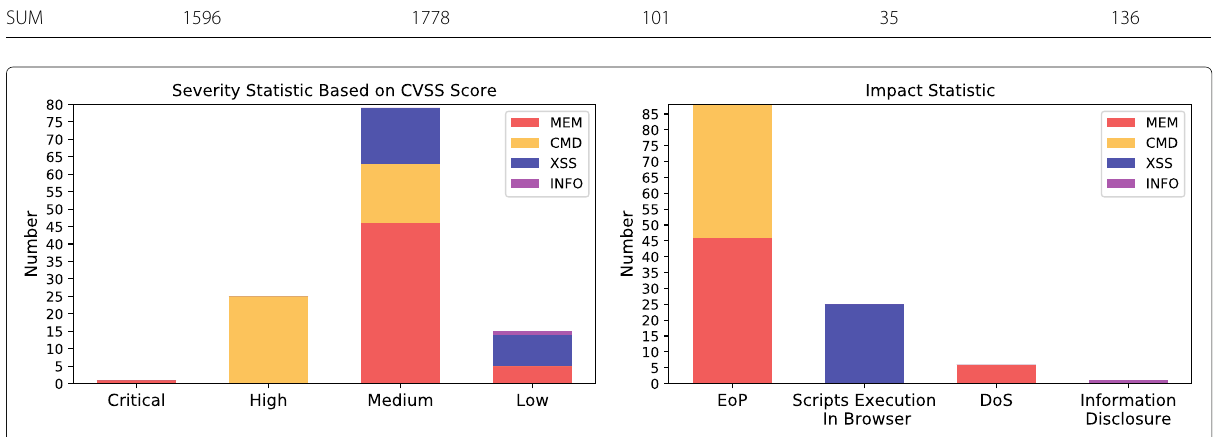
Fig. 9 Impact of Assigned